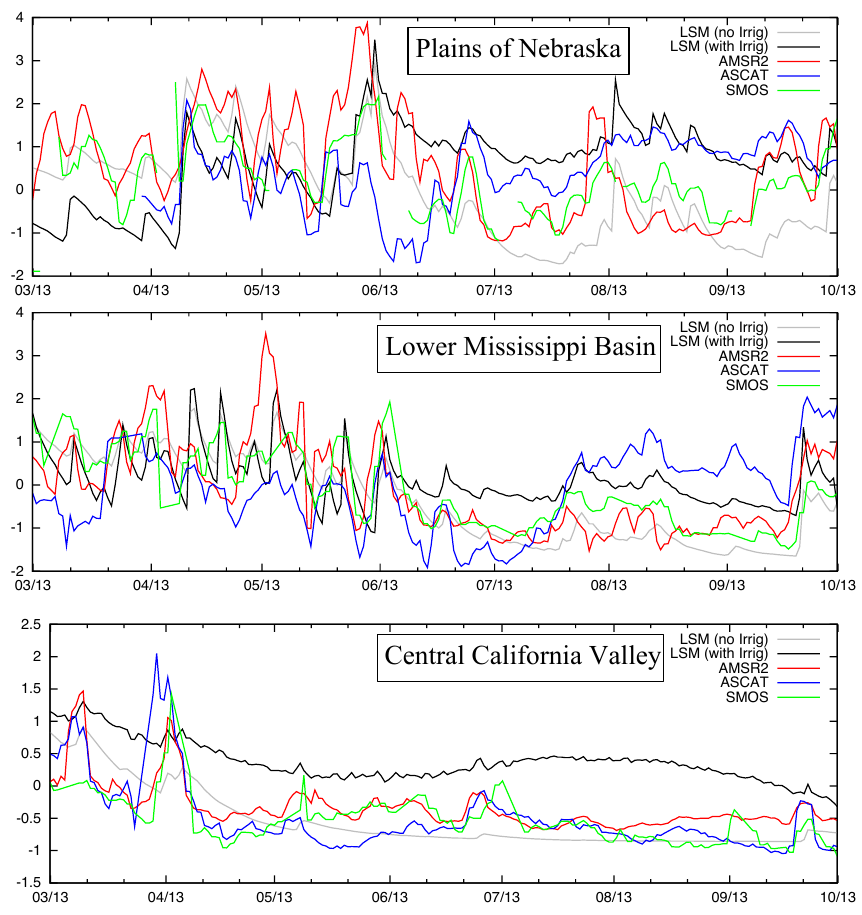
Figure 6. Comparison of normalized soil moisture values from Noah OL simulation, SMOS, AMSR2 and ASCAT retrievals, for three subregions shown in Fig. 1.